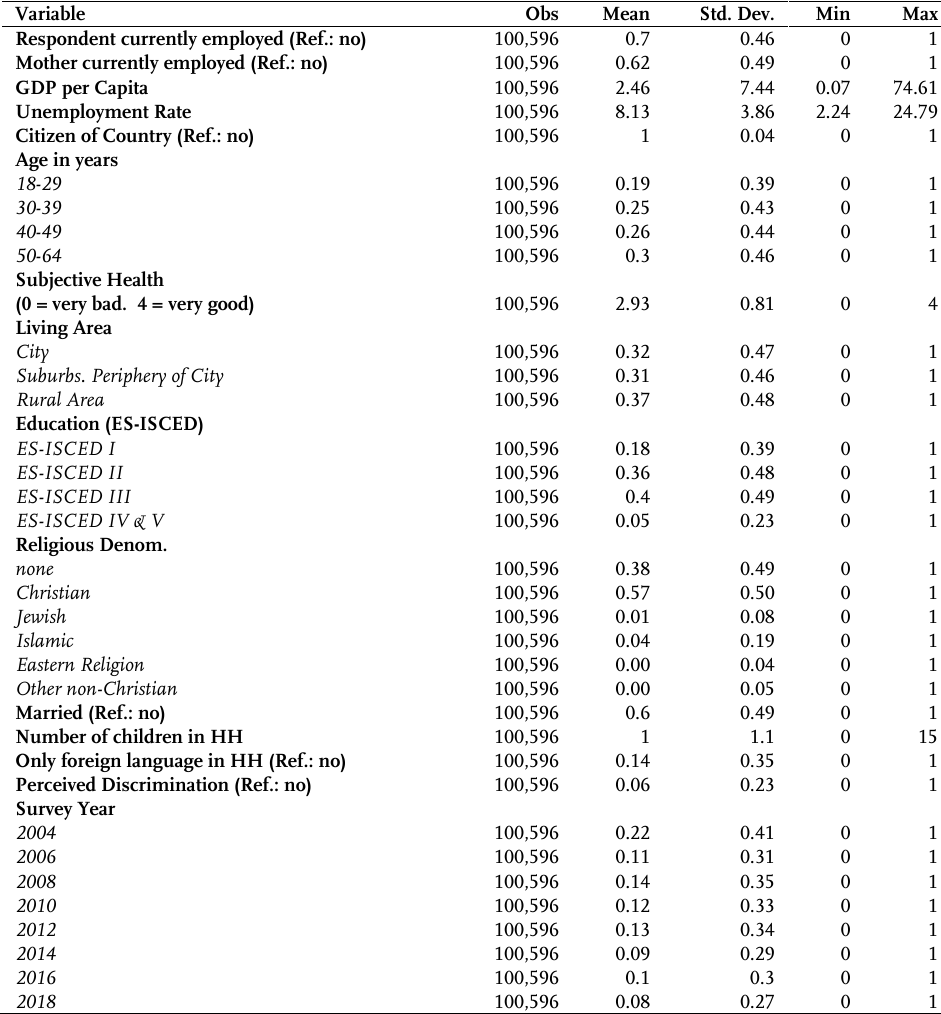
Table A.3 : Descriptive statistics female